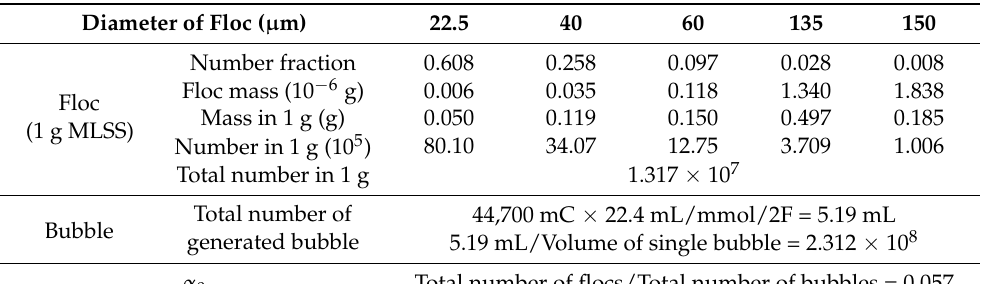
Figure 4. The passed charge for separation of unit mass of activated sludge flocs under variable j and initial MLSS concentration in batch flotation experiments. Table 1. Estimation of the collision-attachment efficiency ( α 0 ) from batch flotation experiments.